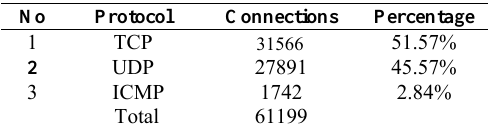
Table.1. Attack connection per